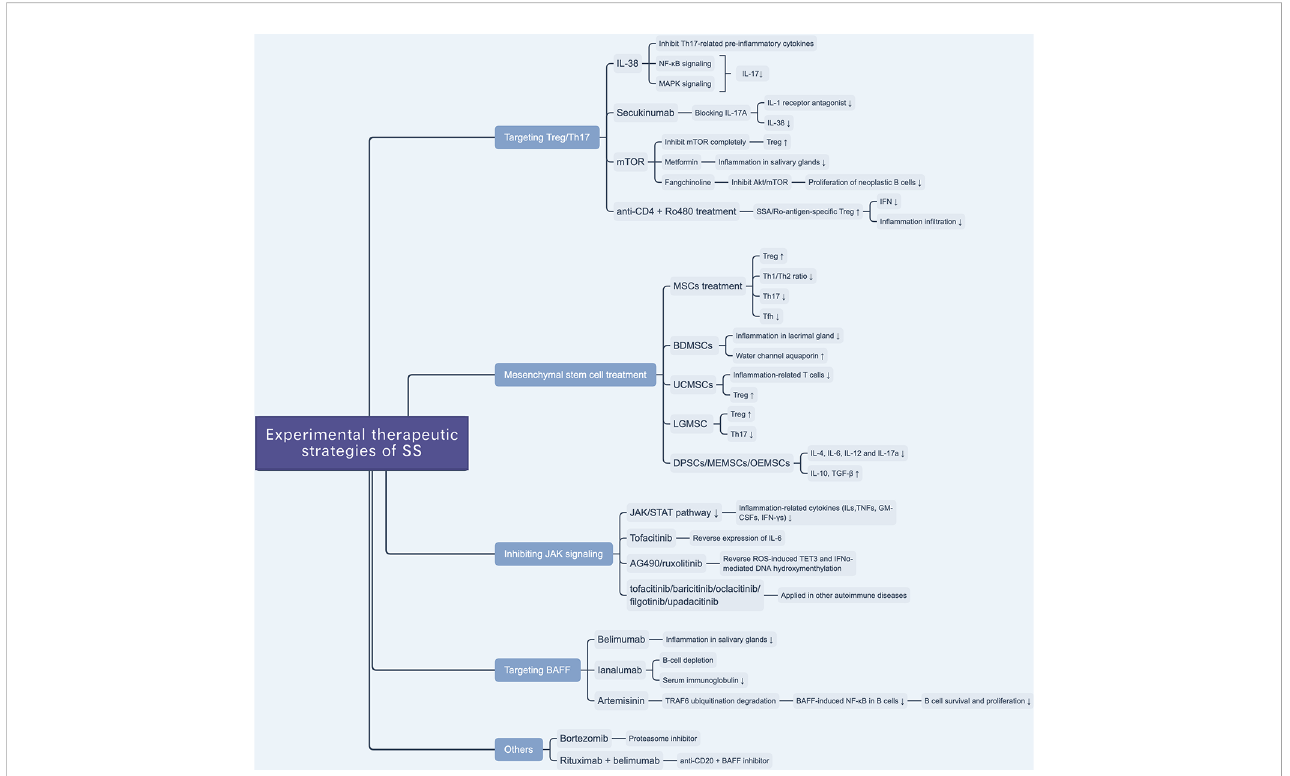
FIGURE 2 Overview of novel experimental therapeutic strategies of SS. There are various experimental drugs (e.g. JAK inhibitors) or schemes (e.g. targeting Treg/ Th17 and BAFF) being investigated for SS treatment. Besides, mesenchymal stem cell treatment is reported to be a promising scheme to treat